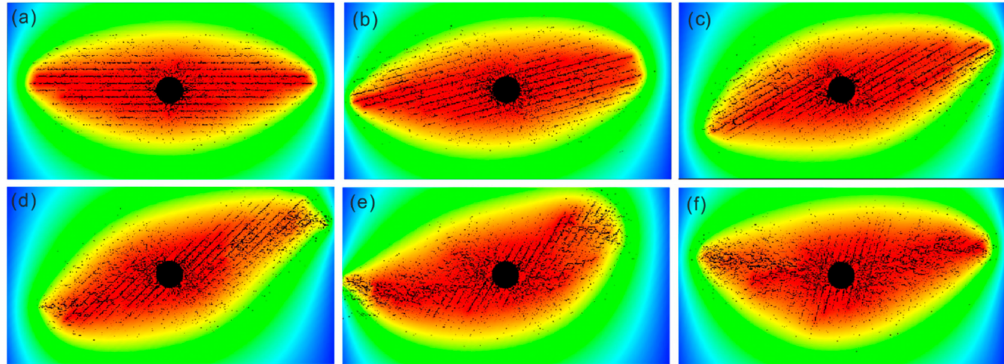
Figure 4. Fracture pattern for bedding orientations of 0 ◦ , 15 ◦ , 30 ◦ , 45 ◦ , 60 ◦ , and 75 ◦ . The color indicates the relative magnitude of the pore water pressure field. The boundary stress and injection rate were the same as the base model. ( a ) Bedding orientation 0 ◦ ; ( b ) Bedding orientation 15 ◦ ; ( c ) Bedding orientation 30 ◦ ; ( d ) Bedding orientation 45 ◦ ; ( e ) Bedding orientation 60 ◦ ; ( f ) Bedding orientation 75 ◦ .